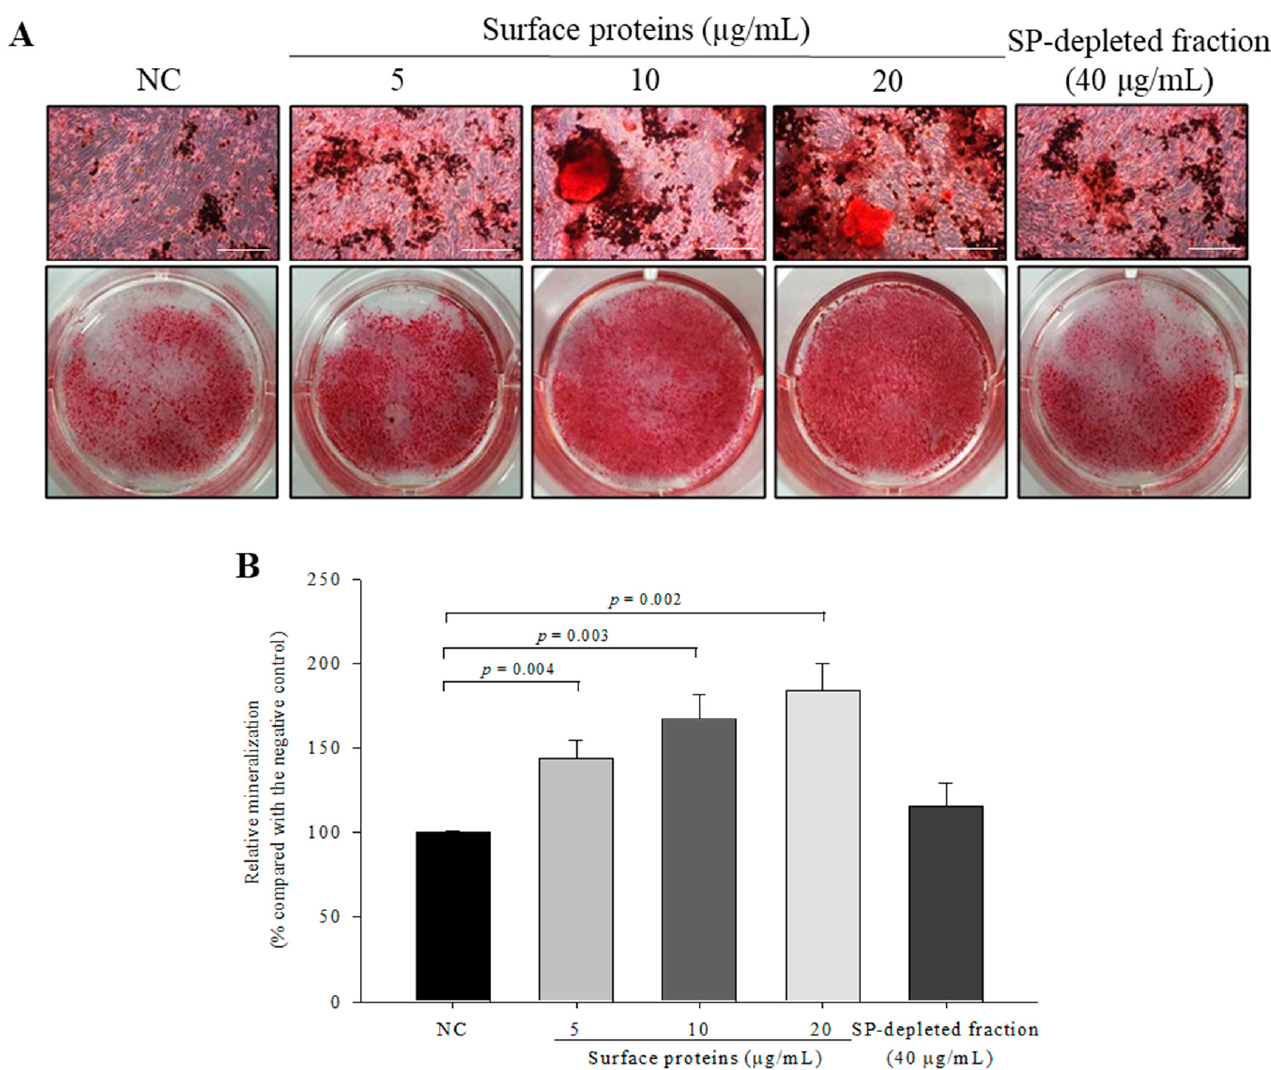
Figure 11. Effect of surface proteins extracted from P. freudenreichii MJ2 on osteoblast mineralization. Calcium deposits were stained by alizarin red S ( × 100, scale bar = 100 µ m) ( A ) and quantified ( B ). Values indicate the mean ± SD of three independent experiments performed in triplicate.